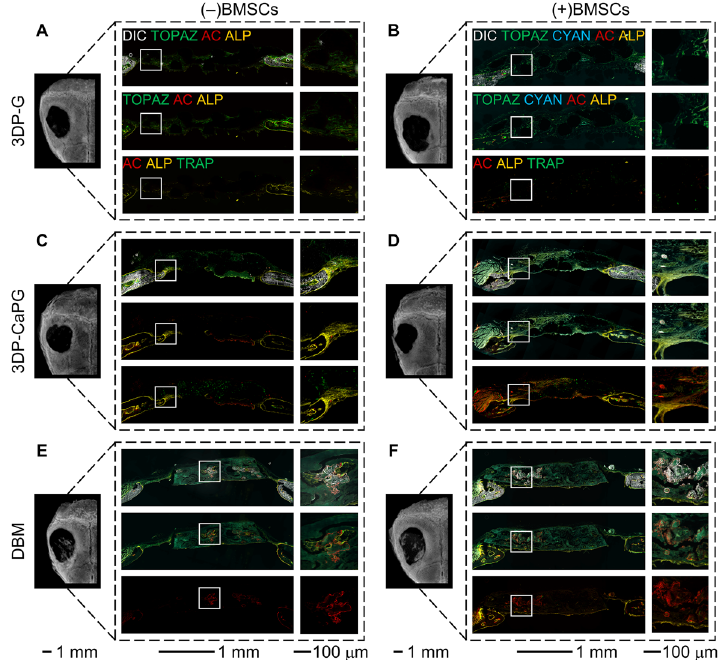
Figure 5. Osteogenic capabilities of 3DP CaPG matrices in a mouse critical size calvarial defect model. Histology overlay images of differential interference contrast (DIC) (grayscale, white mineralized tissue), donor BMSCs (cyan), host cells (topaz), AC (red, active mineralization within the past 24 h prior to sacrifice), ALP (yellow, osteoblast activity), and TRAP (green, resorptive